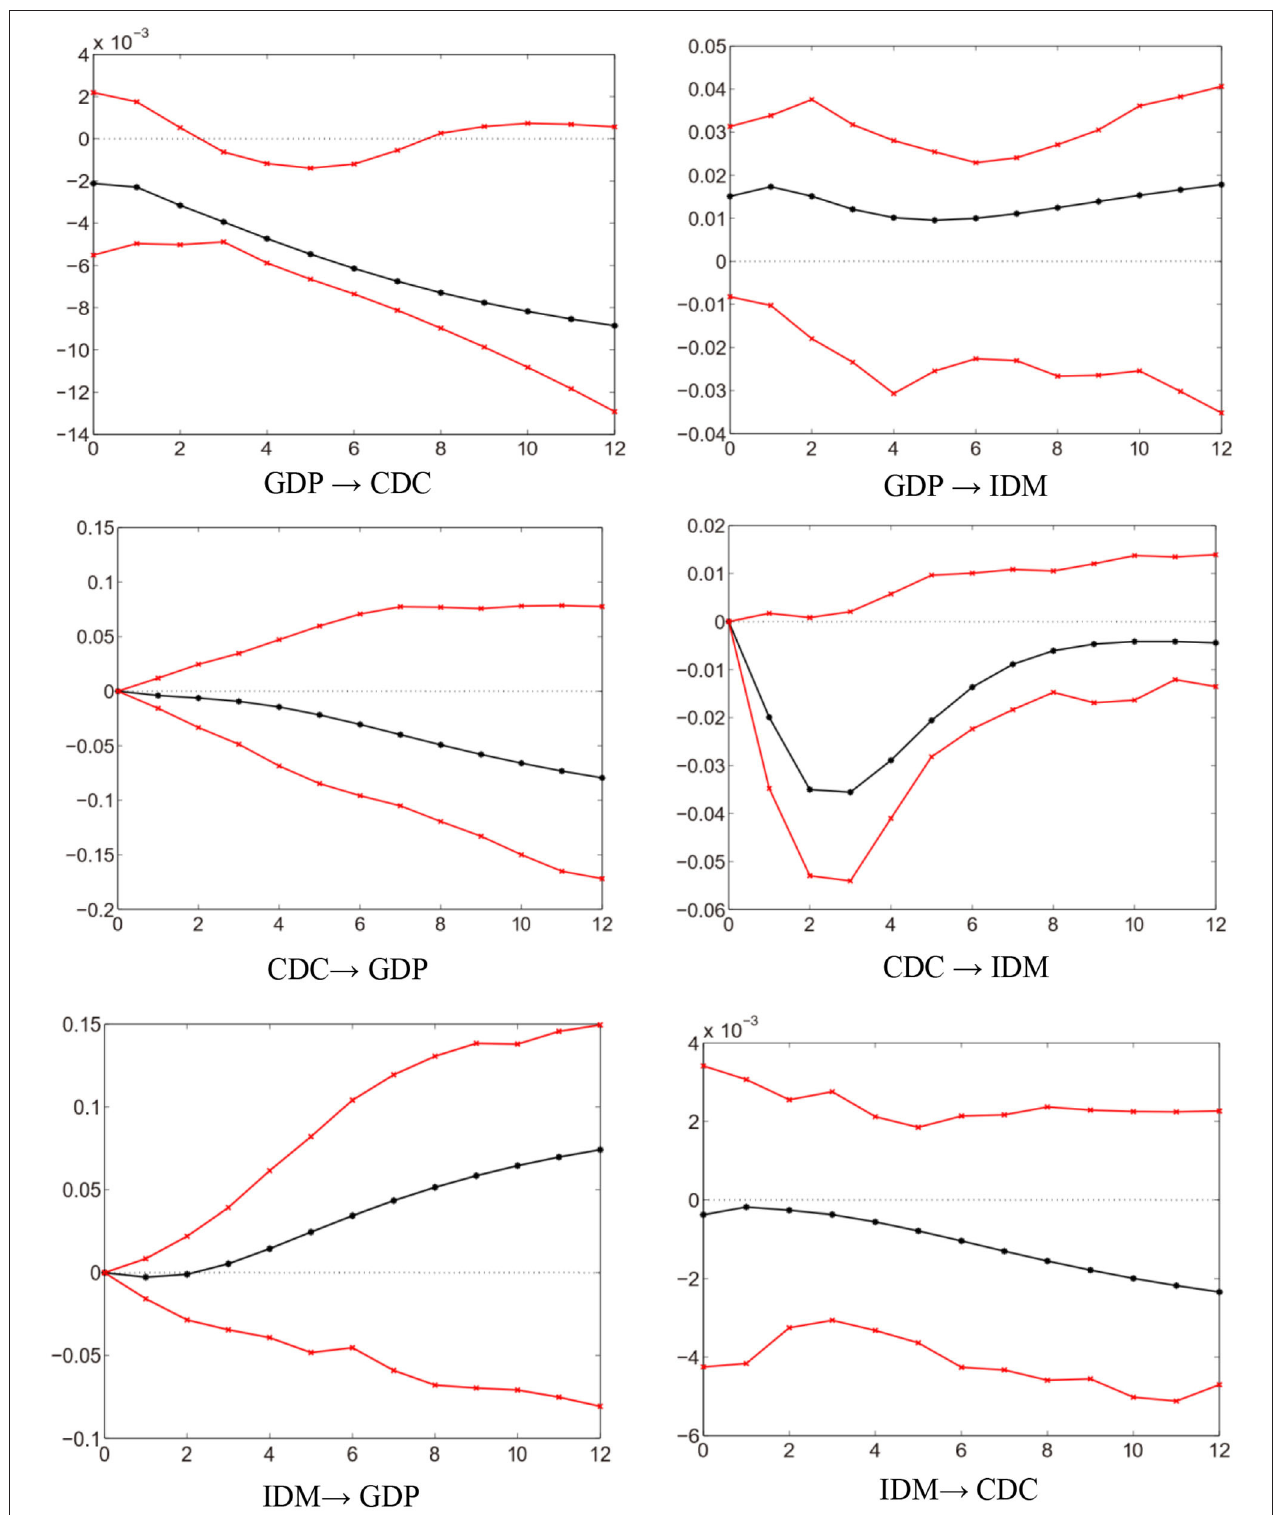
FIGURE 2 | Impulse response functions of LF-VAR